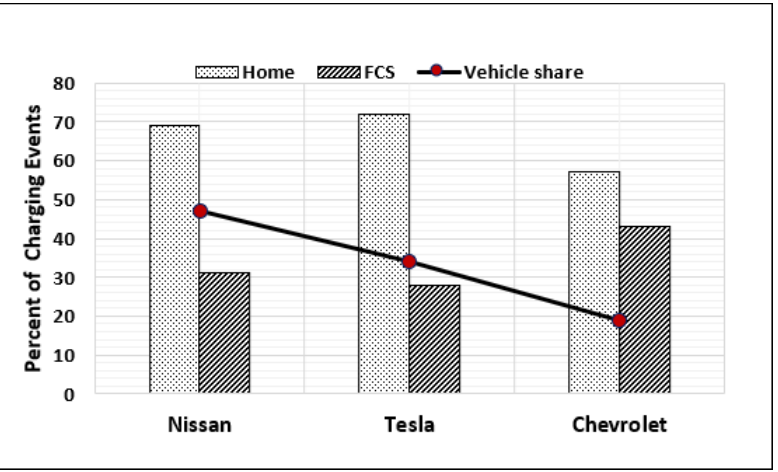
Figure 3. Charging events by location [26].